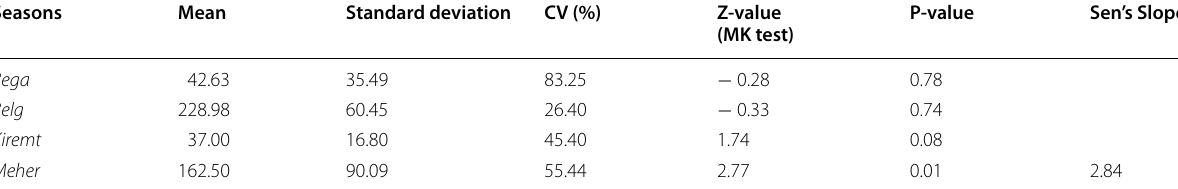
Table 3 Descriptive statistics and test results of seasonal precipitation (1981–2018)